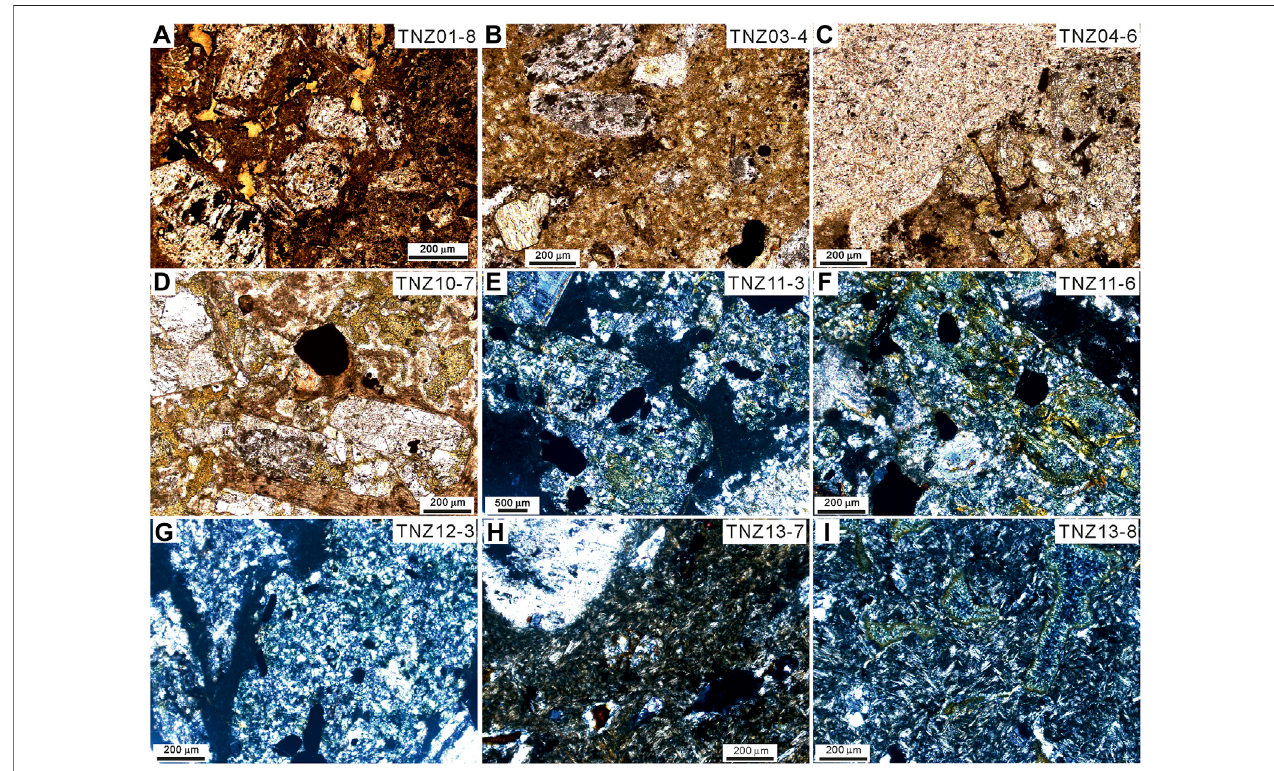
FIGURE 5 | Transmitted-light (A – D) and cross-polarized-light (E – I) photomicrographs for representative samples of the Lower Cretaceous Zonggei Formation volcanic rocks.